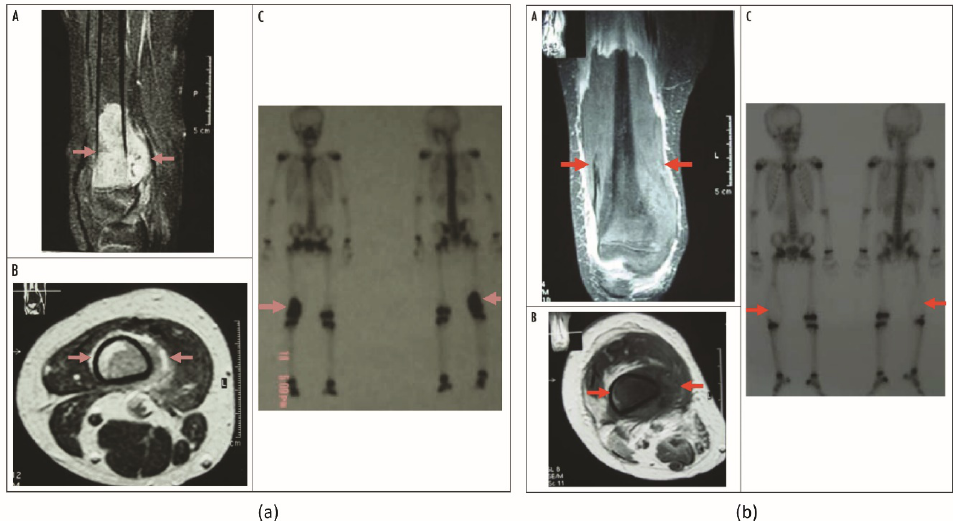
Figure 6. ( a ) Osteosarcoma in inferior segment of right femoral bone after neoadjuvant chemotherapy before HIFU. DCE-MR images obtained from (A) coronal plane and (B) transverse plane show abundant blood supply and survival tumor in the osteosarcoma lesion (red arrow). (C) Static bone imaging of 99m Tc-MDP, with radioactivity concentration in inferior segment of right femoral bone (red arrow); tumor survived. ( b ) The same patient 8 weeks after 2 HIFU treatments. DCE-MR images obtained in (A) coronal plane and (B) transverse plane show no evidence of contrast enhancement in the treated lesion (red arrow), with a papery enhanced band on the verge of inactivated area, which is indicative of complete coagulation necrosis in the osteosarcoma. (C) Static bone imaging of 99m Tc-MDP, with radioactivity concentration disappeared in inferior segment of right femoral bone (red arrow); tumor is inactivated. There is a reaction band along with the verge of inactivated area of tumor with higher radioactive uptake. Figures adapted from Osteosarcoma: Limb Salvaging Treatment by Ultrasonographically Guided High-intensity Focused Ultrasound, Li C, Wu P, Zhang L, Fan W, Huang J and Zhang F, Cancer Biology & Therapy, 15 June 2009, and reprinted by permis- sion from Taylor & Francis Ltd., http://www.tandfonline.com (accessed on 7 December 2022) [41]. To our knowledge, the only prospective two-arm randomized study, which com- pares chemotherapy (adriamycin) combined with HIFU (observation group, OG, n = 36) with chemotherapy alone (control group, CG, n = 36) for treatment of osteosarcomas was presented by Chunqiu Wang [45]. Assessment of efficacy, classified as CR, PR, SD, PD, was performed using the RECIST criteria of the WHO. For the OG, the overall response (88.9%) and disease control rate (94.4%) were found to be significantly higher compared with the CG (66.7% and 75.0%, respectively). While the survival did not differ during the first year of follow up, survival rates at 2 (69.4%) and 3 years (38.9%) were significantly higher in the OG compared with control (2y: 52.8%; 3 y: 22.2%), indicating a survival ben- efit for patients receiving the combined treatment protocol. Adverse events were related to chemotherapy and did not differ for OG and CG suggesting that HIFU does not increase chemo-related side effects nor adds extra side effects. Adjacent analysis of blood markers indicated an increase of TNF- α, IL -2 and IL-8, which was higher for the OG compared with CG. As TNF- α and ILs are cytokines that can strengthen the immune response, a protocol combining adriamycin with HIFU may be able to enhance the therapeutic out- come via activation of the immune system. Table 2 summarizes the publications on HIFU treatment of primary malignant bone tumors with their respective clinical outcomes and adverse events.